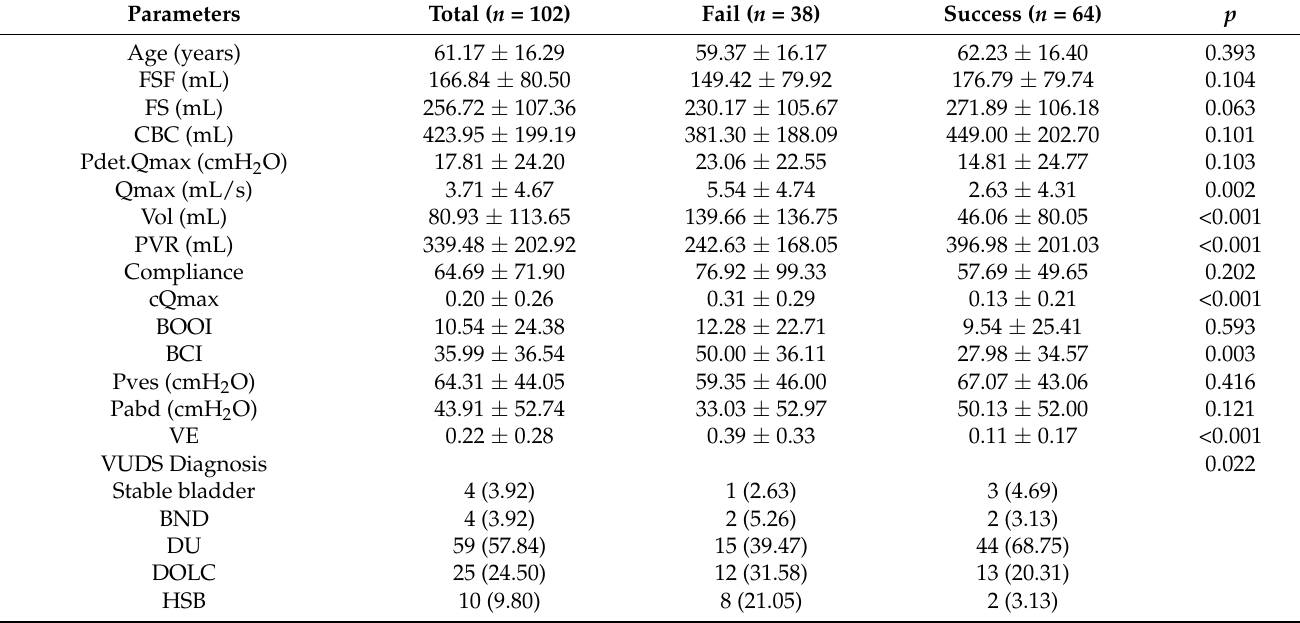
Table 1. The baseline videourodynamic parameters and diagnosis of patients among successful and failed